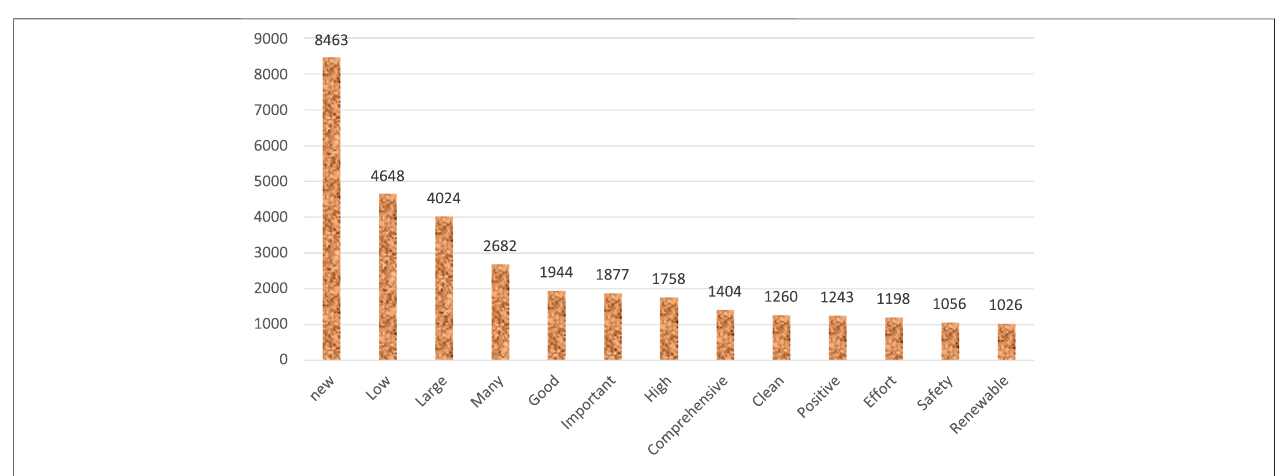
FIGURE 16 | Frequency of most mentioned adjectives in carbon neutrality.